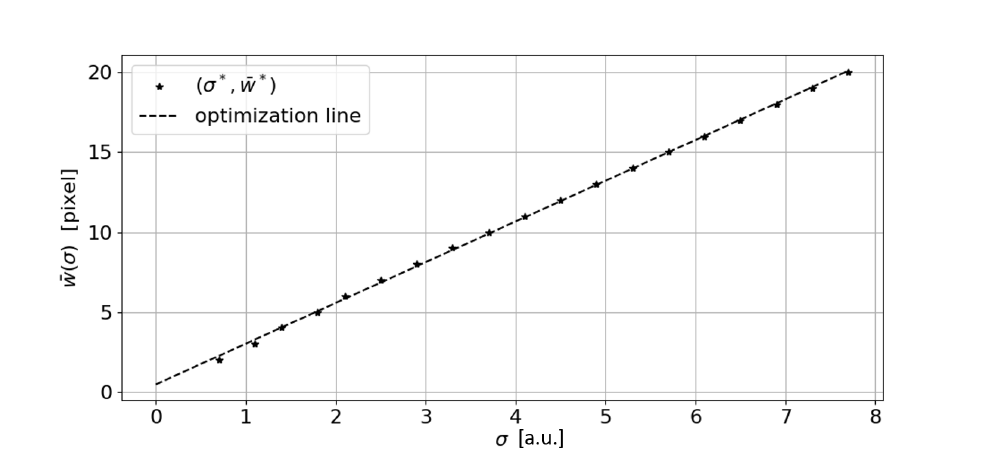
Figure 12. The σ optimization line (dashed line) vs. ( σ ∗ , ¯ w ∗ ) points obtained by iteratively applying the algorithm on synthetic line widths ranging from 2 to 20 pixels with s = 0.1 (a.u.: arbitrary